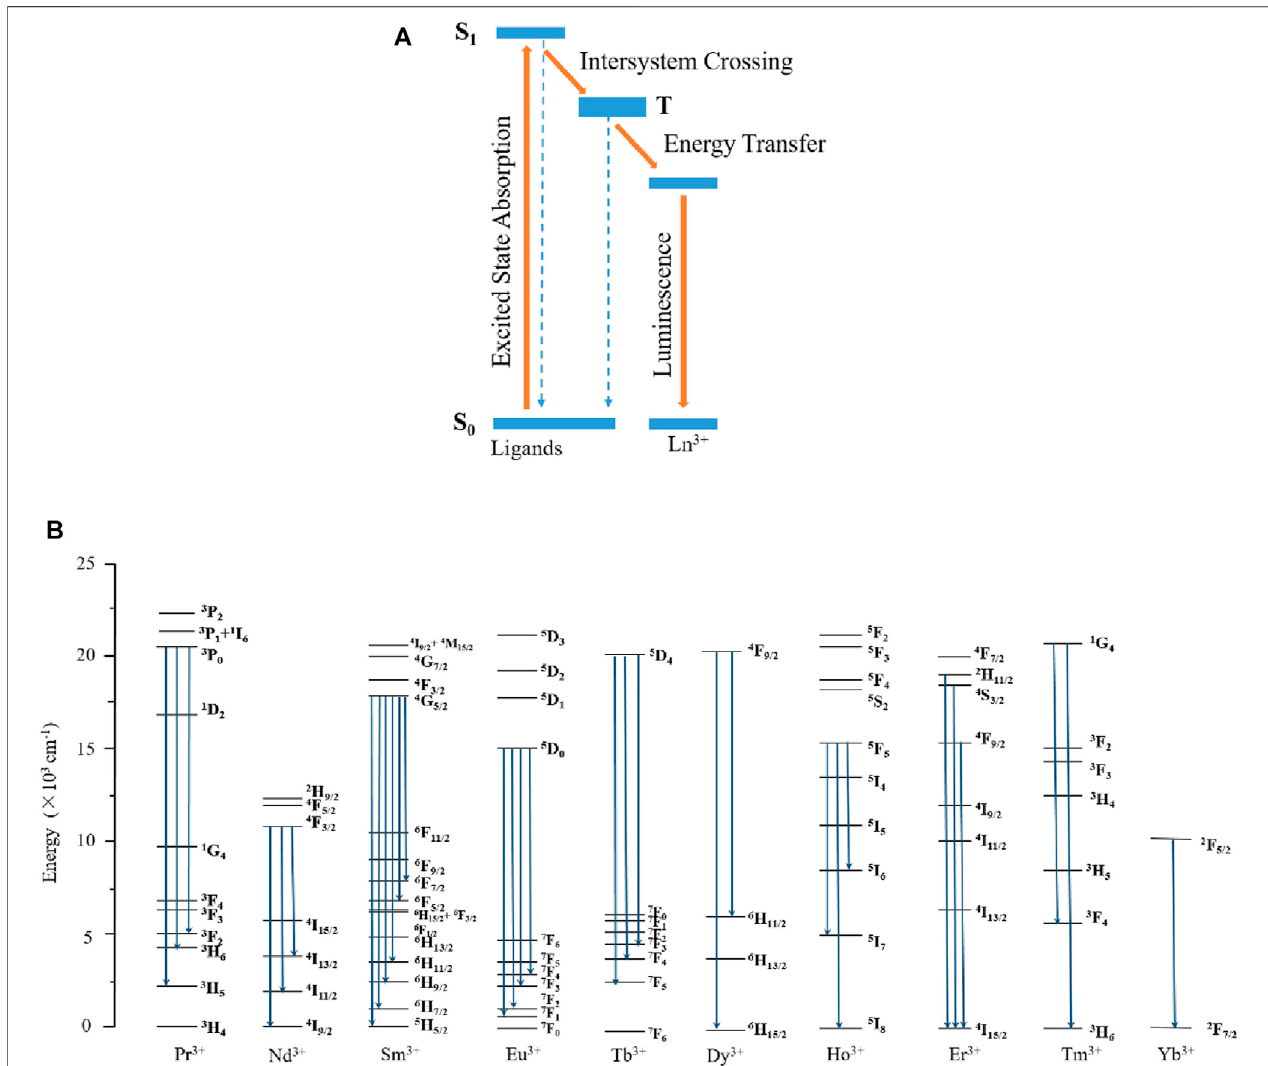
FIGURE 2 |(A) The diagram ofthe main energy fl ow paths during the sensitization of lanthanide luminescence via the ligands. (B) The diagram of the energy levels of Pr 3+ , Nd 3+ , Sm 3+ , Eu 3+ ,Tb 3+ , Dy 3+ ,Ho 3+ , Er 3+ , Tm 3+ , and Yb 3+ ions.